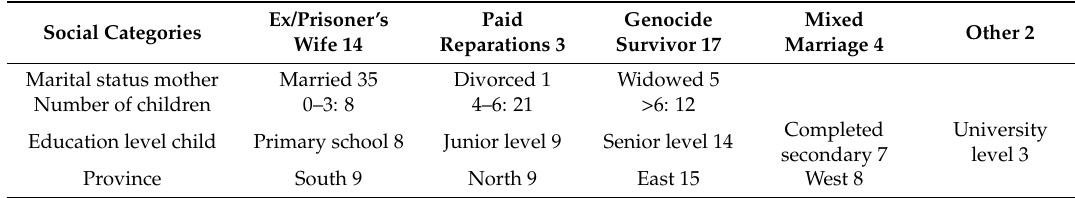
Table 1. Background information on